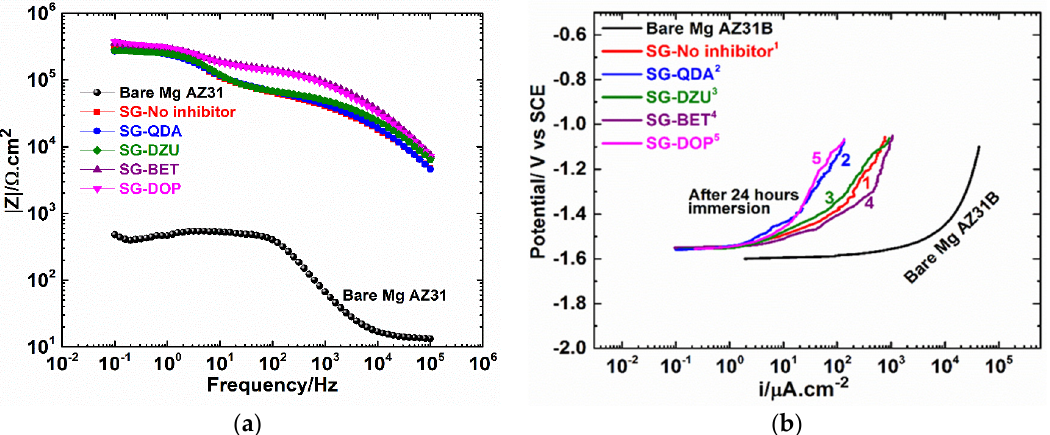
Figure 5 . ( a ) EIS Bode modulus plots and ( b ) anodic polarization curves, of coatings with and without